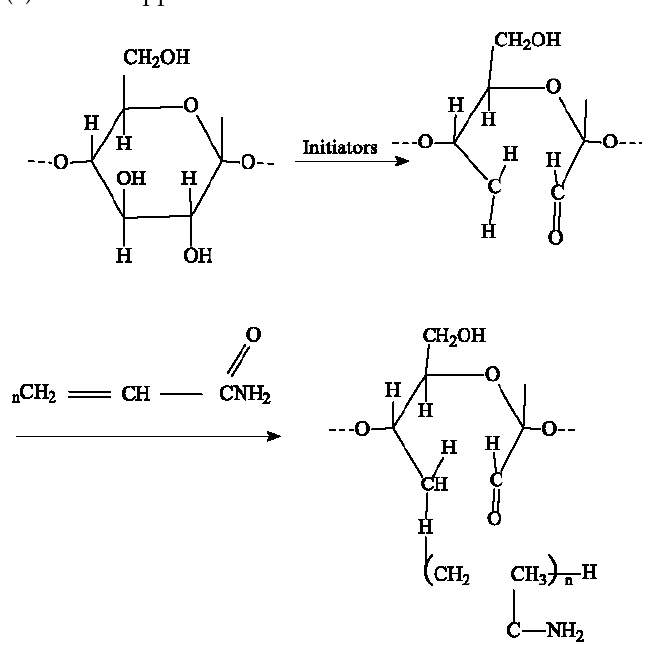
Figure 5. ((C 6 H 10 O 5 ) n ) and ([-CH-CH 2 -CH-CH 2 -] n CONH 2 ) reaction process.